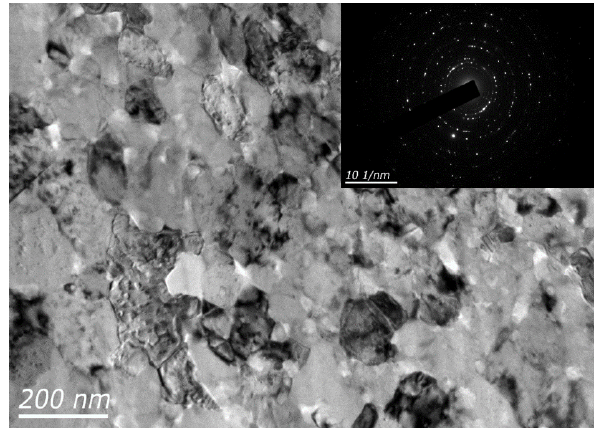
Figure 5: Bright field image of TEM and corresponding diffraction pattern (Inset of the picture), illustrating the mixture of Cu grains and Cr 2 O 3 oxides.